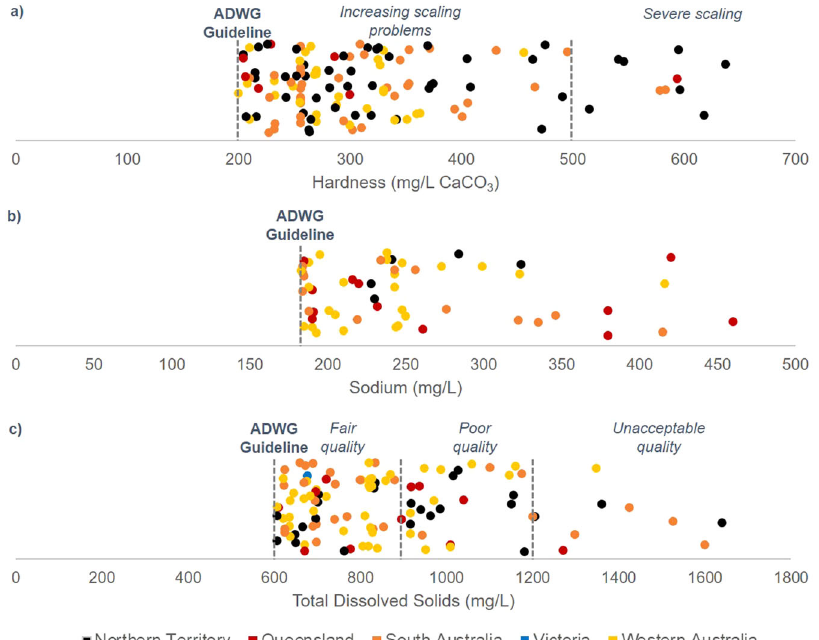
Fig. 5 Mean values of key aesthetic characteristics in regional and remote locations of Australia where aesthetic guideline values of the ADWG were reportedly not achieved in 2018 – 19. a Hardness. b Sodium. c Total dissolved solids. Note: No public data available for water systems supplied by the Tasmanian government-owned water utility and New South Wales local water utilities. Source data are provided as a Source Data fi